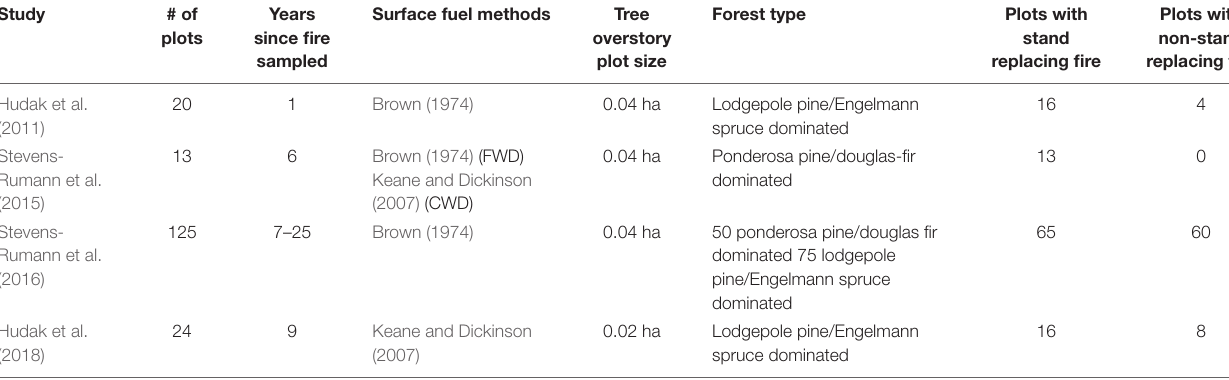
All sites listed here burned once and were only used in the GLM analyses. TABLE 2 | Climate variables derived from Rehfeldt (2006) climate models.